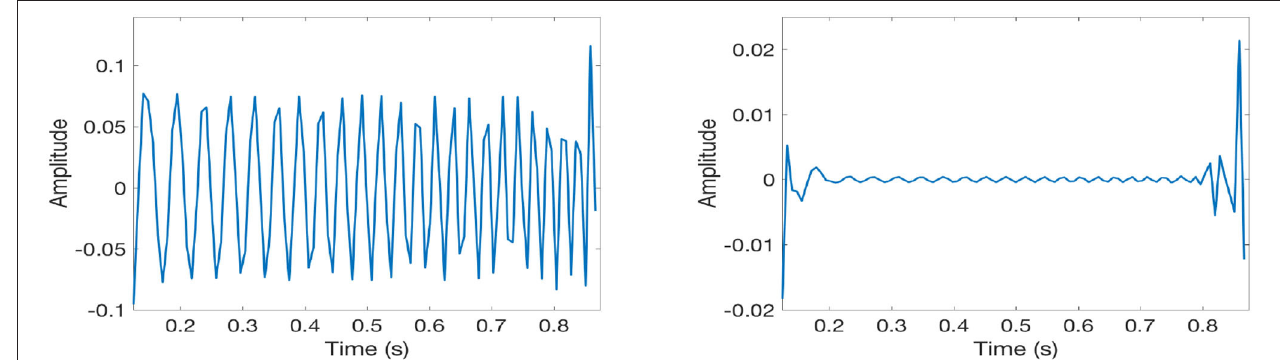
FIGURE 2 | Recovery errors for x ( t ) given in (43) on [0.125,0.875) by FSST (left) and IFE-FSST (right) .